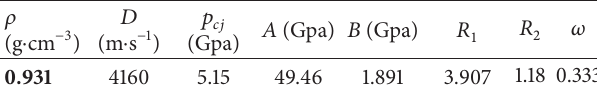
Table 3: Parameters of ANFO [29].